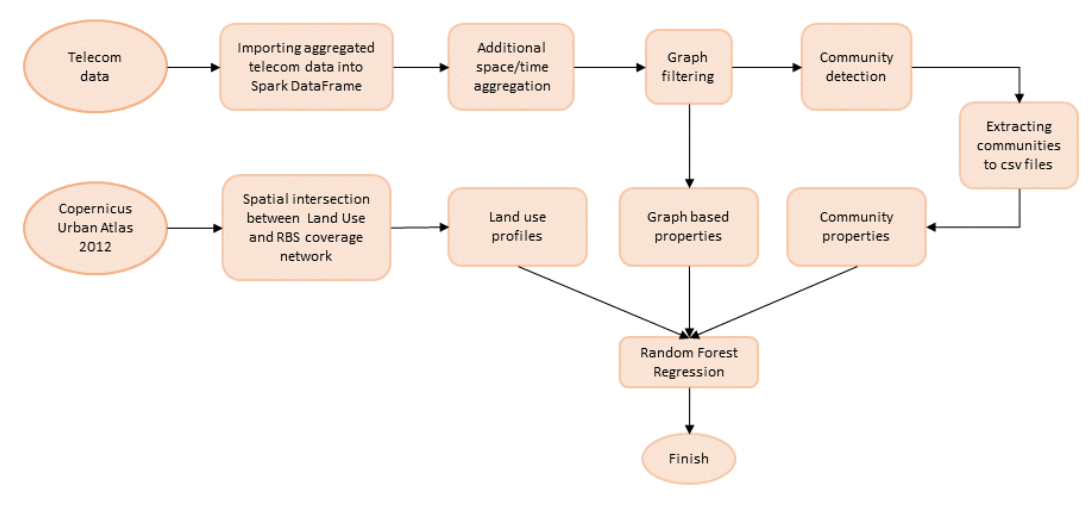
Figure 4. The pipeline of the proposed